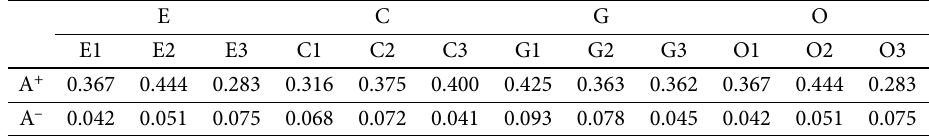
Table 8. The final ranking of digital content industry S + S – C * Ranking (A1) Digital games 0.338 0.257 6 (A2) Computer animation 0.827 0.507 0.380 3 (A3) Digital video applications 0.740 0.722 0.494 2 (A4) Digital learning 0.823 0.393 0.323 4 (A5) Digital publishing 0.851 0.387 0.312 5 (A6) Digital archive 0.647 0.694 0.518